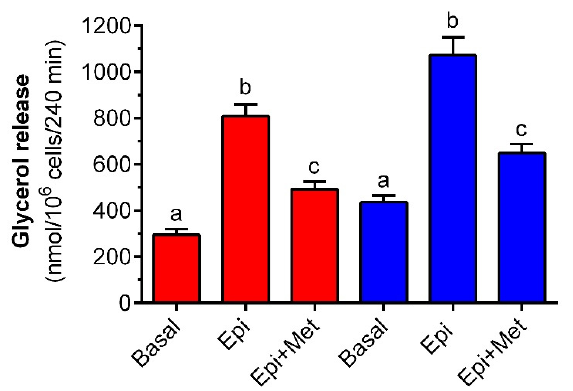
Figure 3. The effects of metformin on epinephrine-induced glycerol release in isolated rat adipocytes in the presence of low and high concentrations of glucose. Adipocytes were preincubated for 3 h with or without 1 mM metformin in the buffer containing 3 mM glucose (red bars) or 12 mM glucose (blue bars). Then, 0.5 µ M epinephrine was added to all cells (except for basal) and incubations were performed for an additional 1 h. After the end of the incubations, adipocytes were removed and the glycerol content in the buffer was determined. Epi—epinephrine, Met—metformin. The obtained results represent the mean ± SEM from 3 independent experiments in 5 repetitions ( n = 15). Values marked by different letters within each experimental group differ significantly at p <